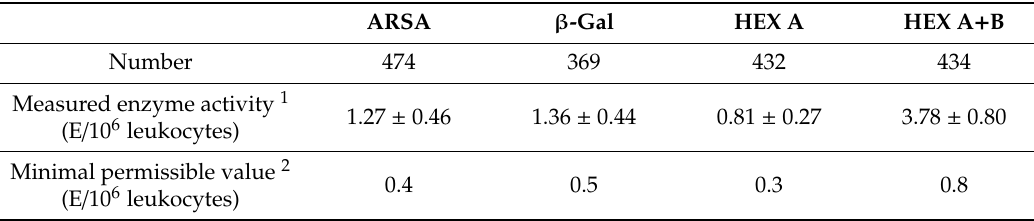
Table 3. Enzyme activity of normal cohort and minimal permissible